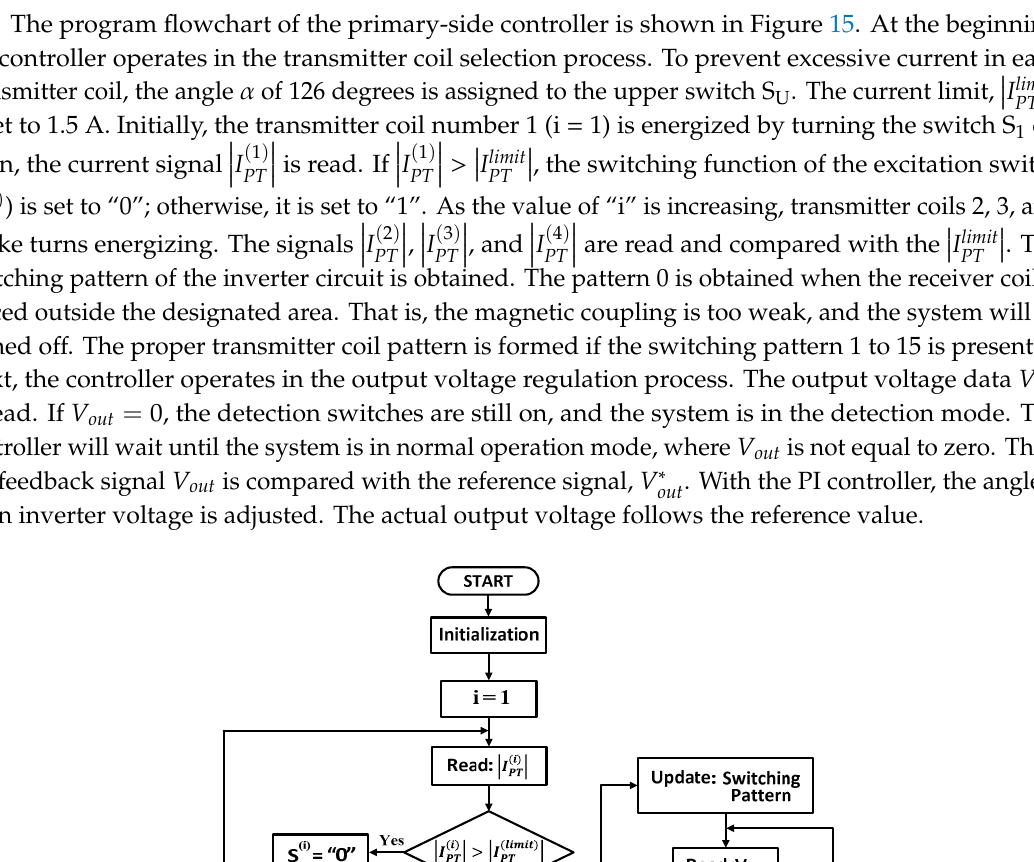
Figure 15. Program flowchart of the primary-side controller.